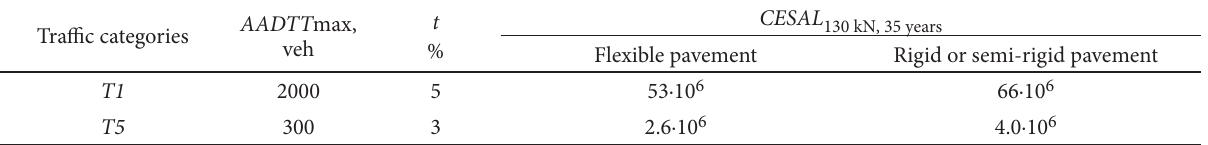
Table 1. Traffic categories Traffic